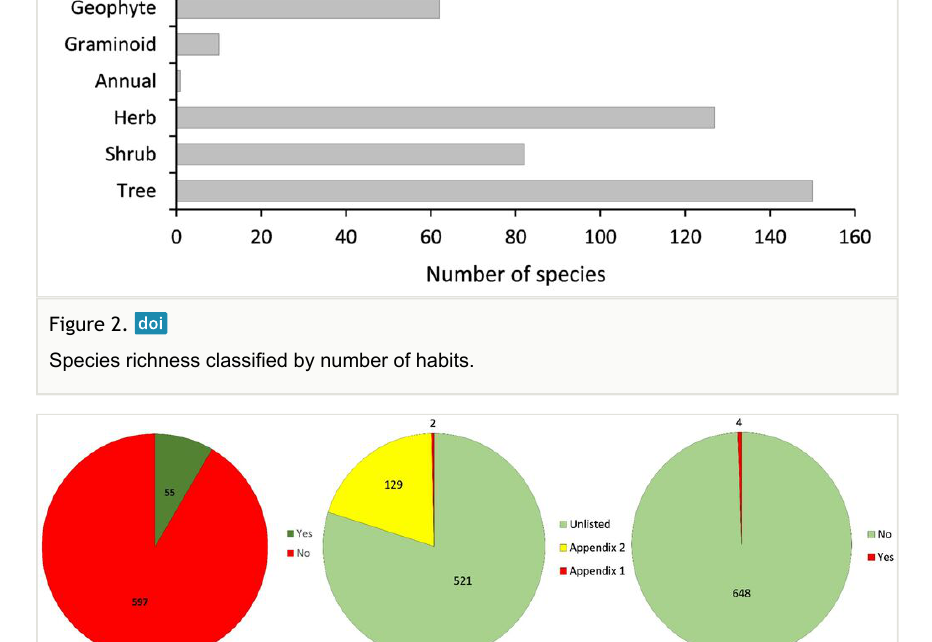
Figure 3. The number of Javan endemic plants that have been conserved (Yes) at ex -situ collections (left), listed on the CITES appendices (middle) and protected by the national law of Indonesia